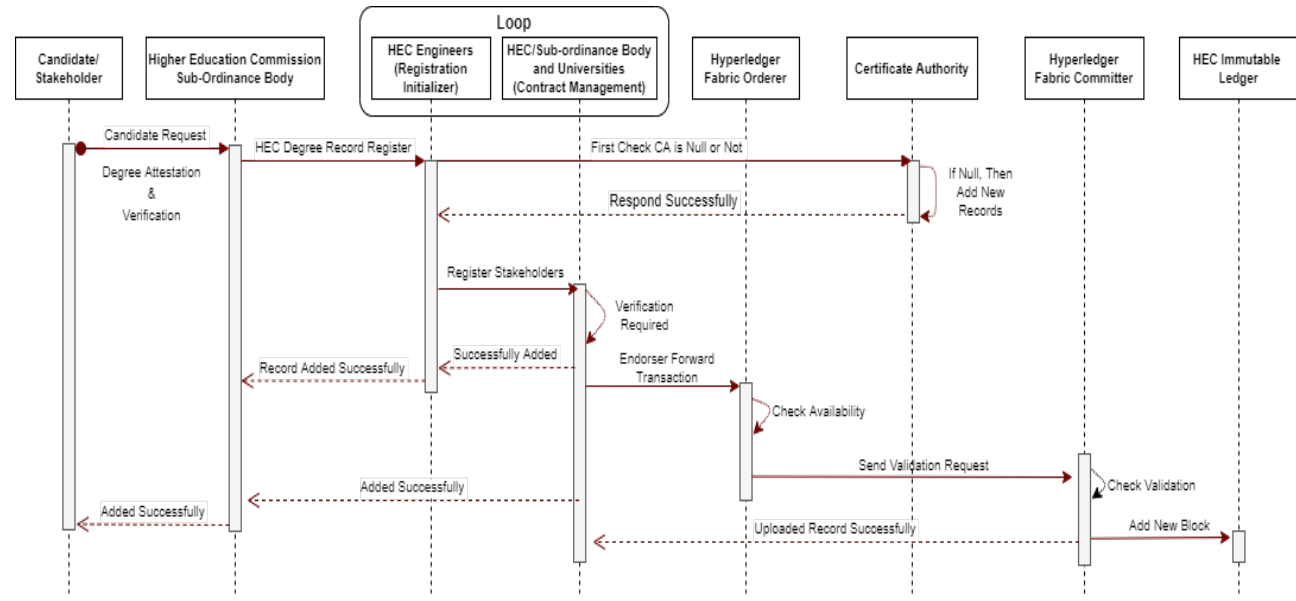
Figure 6. Sequence diagram of degree attestation and credentials verification, and validation of registration of node trans- action processes.